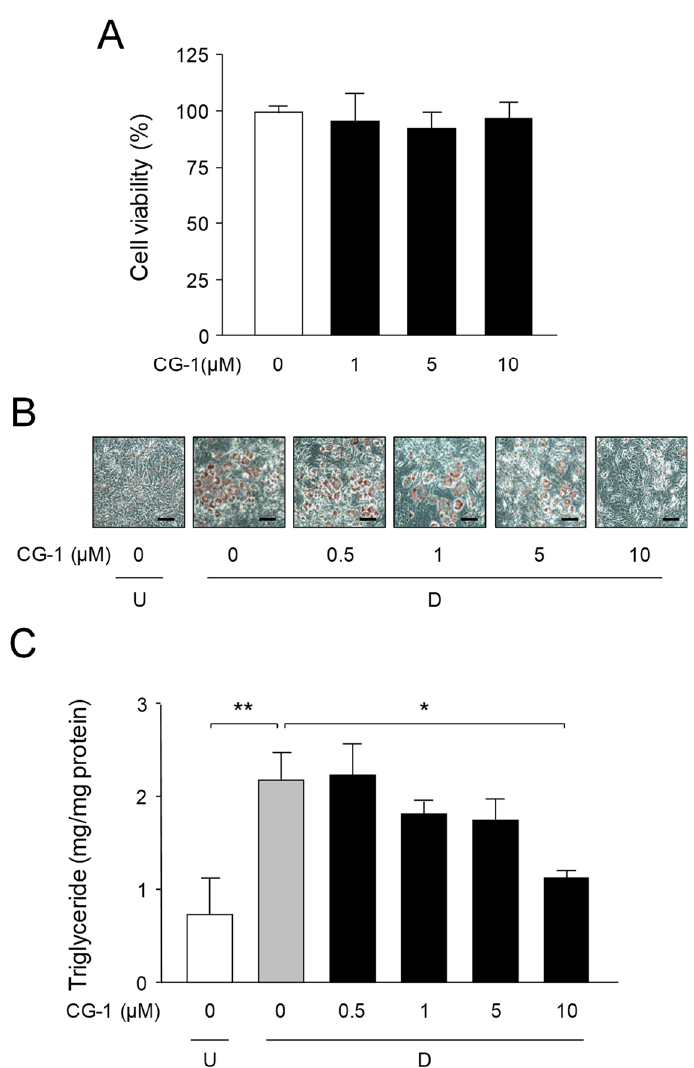
Figure 2. Suppression of intracellular lipid accumulation by CG-1. ( A ) Cytotoxicity of CG-1 in 3T3-L1 cells. The cells were incubated for 6 days in DMEM with various concentrations of CG-1 (0-10 µ M). Data show the means ± S.D. from three experiments. ( B ) Oil Red O staining of intracellular lipid droplets. 3T3-L1 cells (undifferentiated cells: U) were differentiated into adipocytes (D) for 6 days in DMEM with various concentrations of CG-1 (0–10 µ M). The cells were observed by a microscope (200x). Scale bar = 200 μ m. ( C ) The intracellular triglyceride level. 3T3-L1 cells (undifferentiated cells: U; white column ) were differentiated ( D ) into adipocytes for 6 days in DMEM without ( gray column ) or with CG-1 (0.5, 1, 5, 10 μ M; black columns ). Data are presented as the means ± S.D. from three experiments. * p < 0.01, ** p < 0.05, as indicated by the brackets. The intracellular triglyceride level was decreased in a concentration-dependent manner and was lowered by approximately 50% at 10 μ M CG-1 in the adipocyte differentiated 3T3-L1 cells (Figure